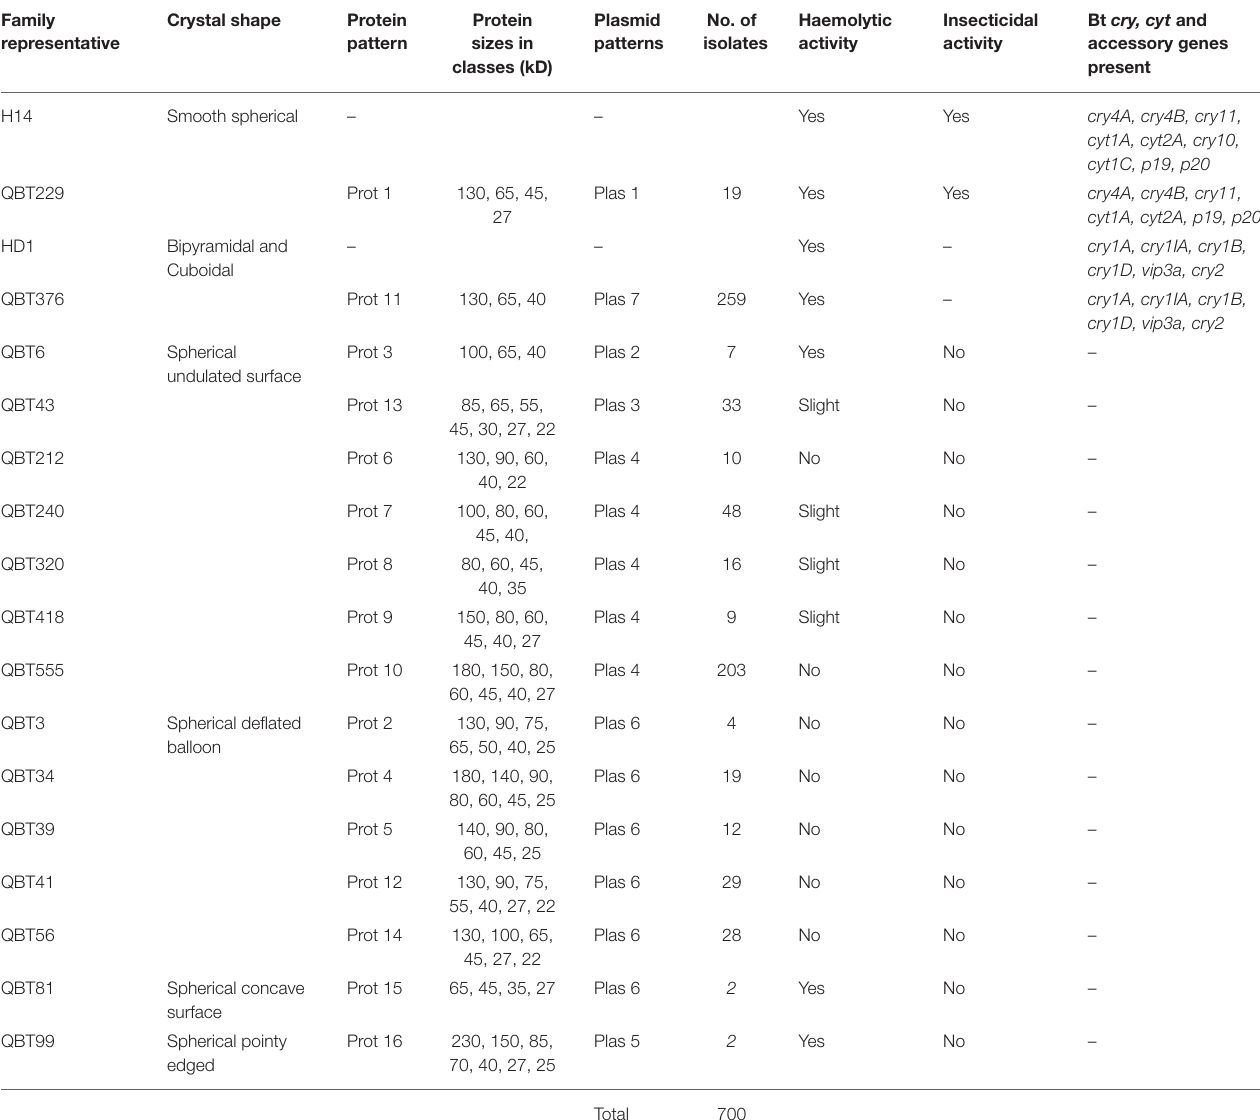
TABLE 2 | Qatari Bt strains collection summarized into 16 classes with the help of true representatives selected based on crystals morphology, proteomic, and genomic characteristics; QBT229 is the representative of Qatari Bti like isolates, QBT376 is the representative of Qatari Btk like isolates, others represent different spherical crystal morphologies observed with various protein and plasmid